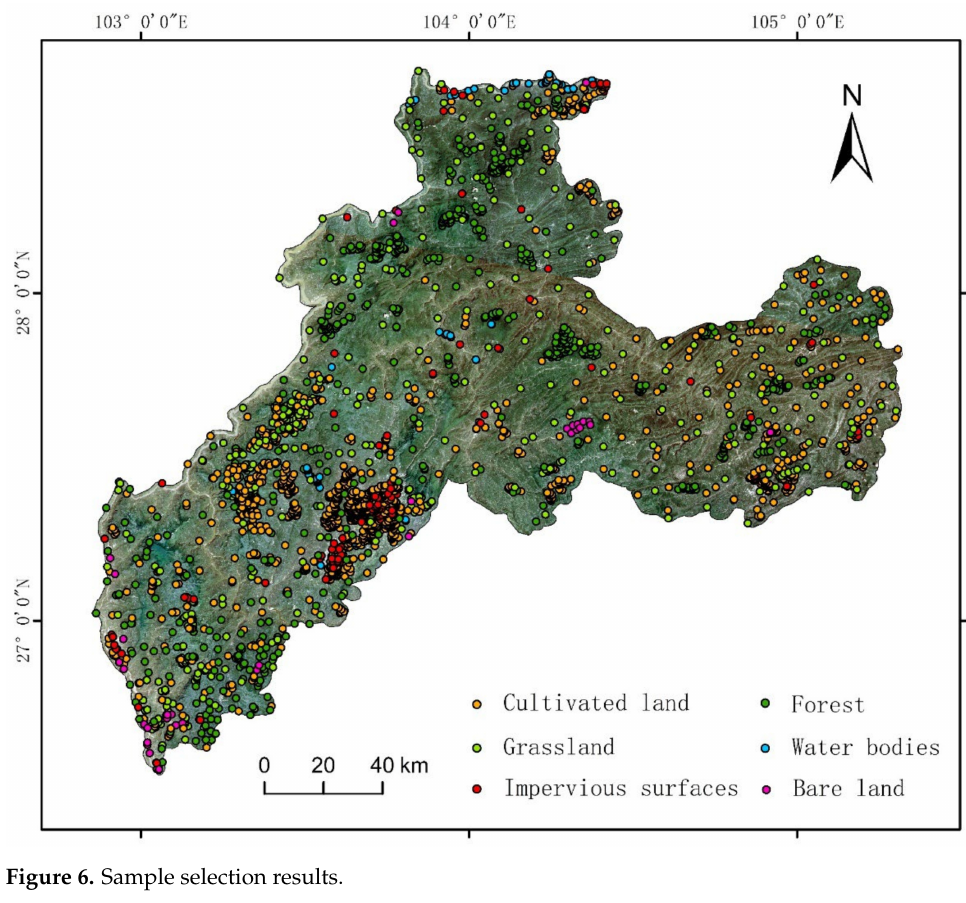
Figure 6. Sample selection results.